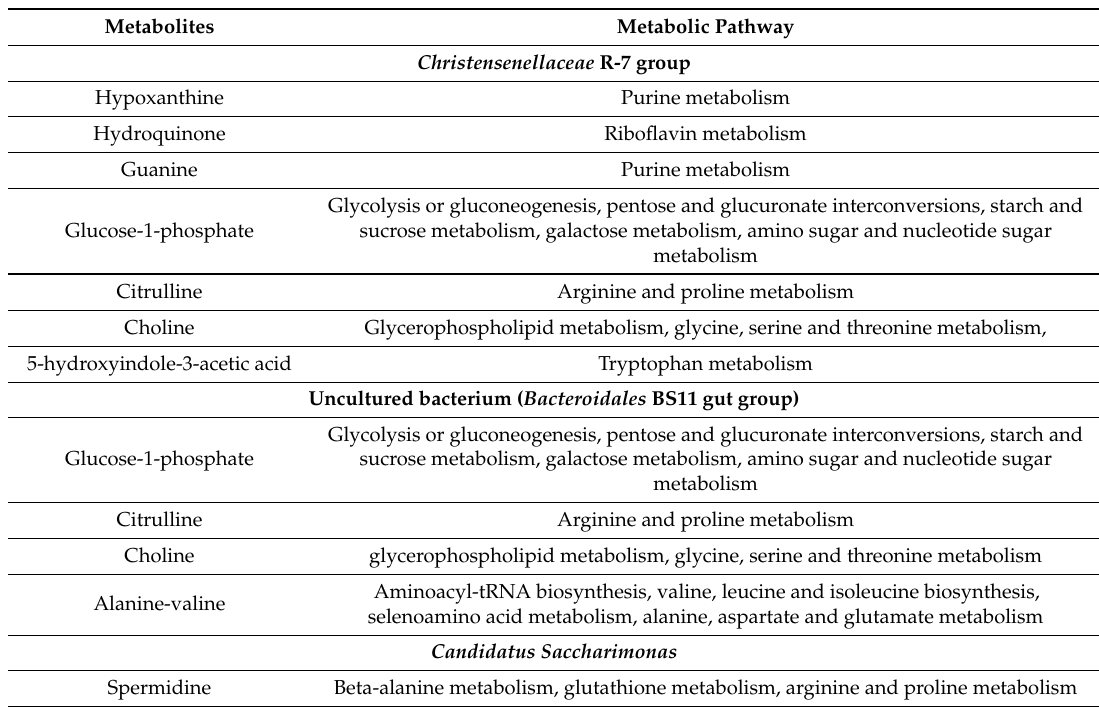
Table 4. List of metabolites associated with dominant rumen bacteria (>1%) affected by live yeast supplementation and their associated metabolic